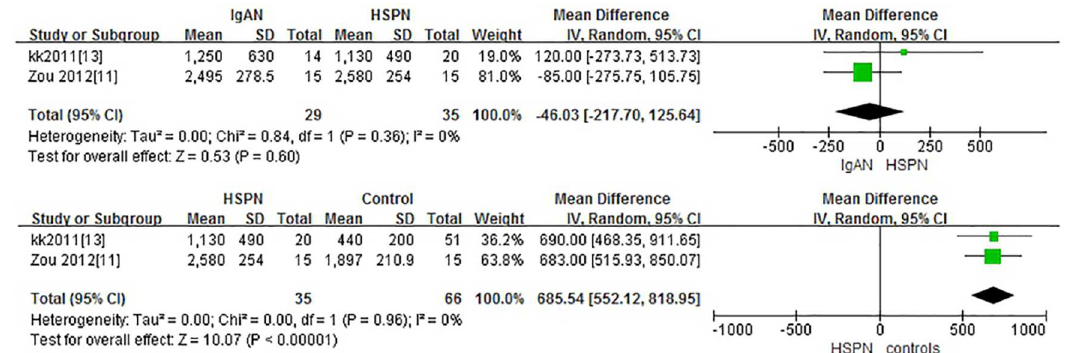
Fig 4. The forest plots of the comparation among IgAN group, HSPN group and controls.